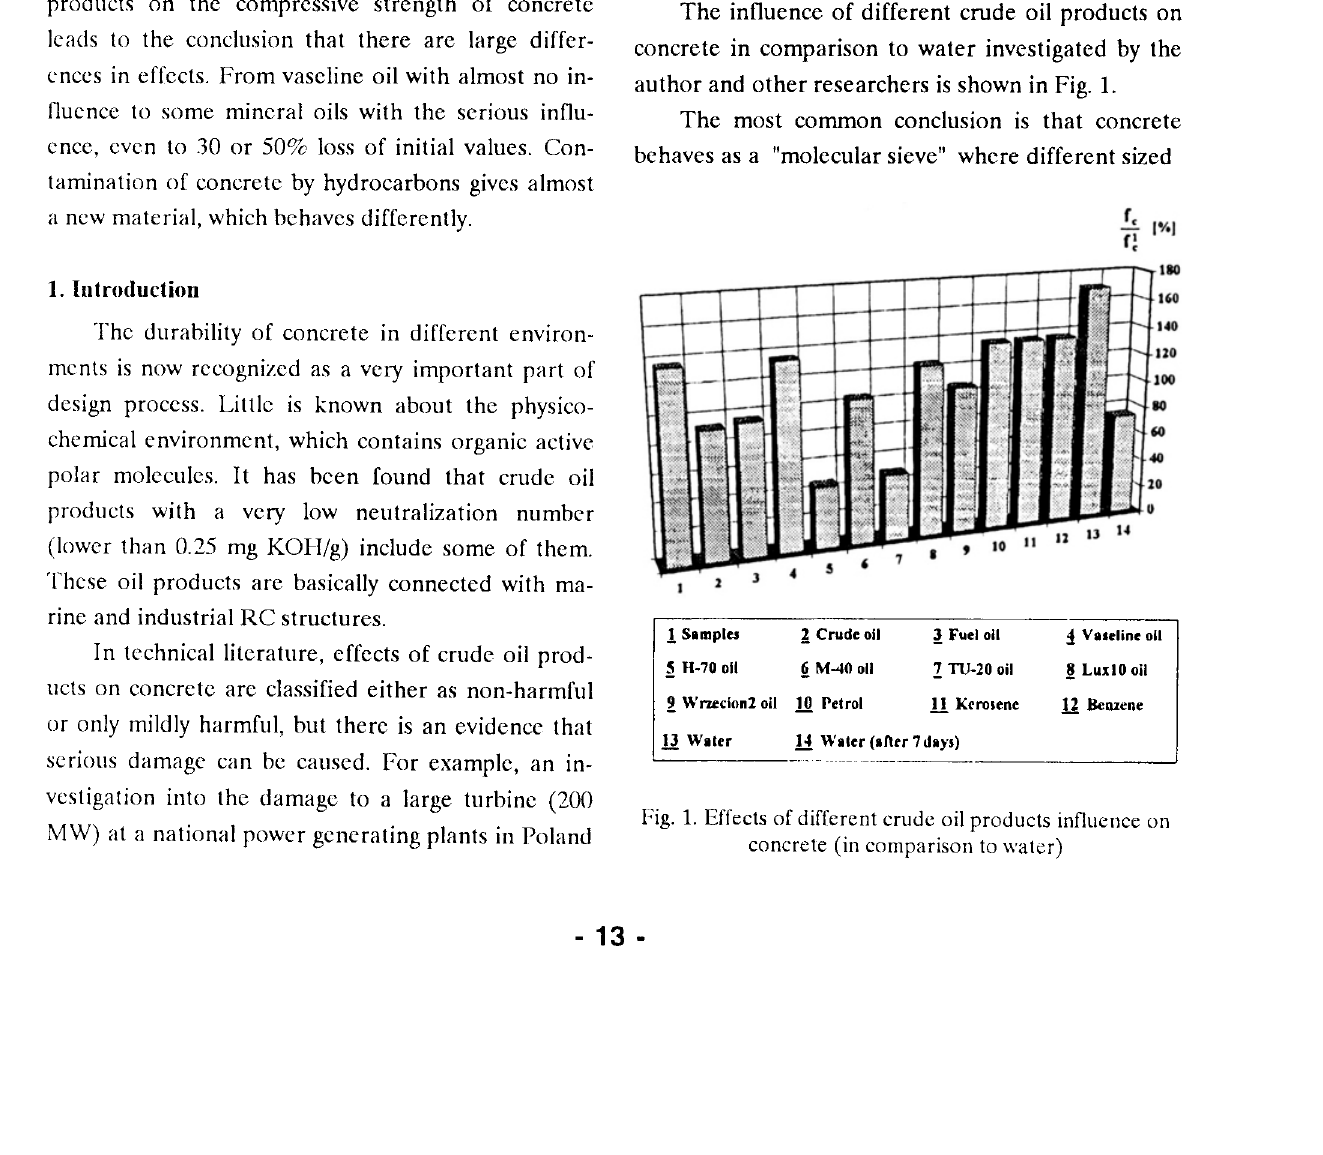
Fig. 1. Effects of different crude oil products influence on concrete (in comparison to